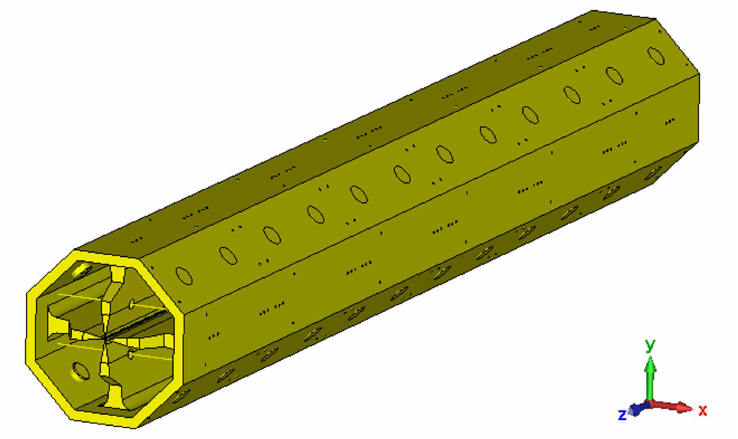
Figure 12. Full-length